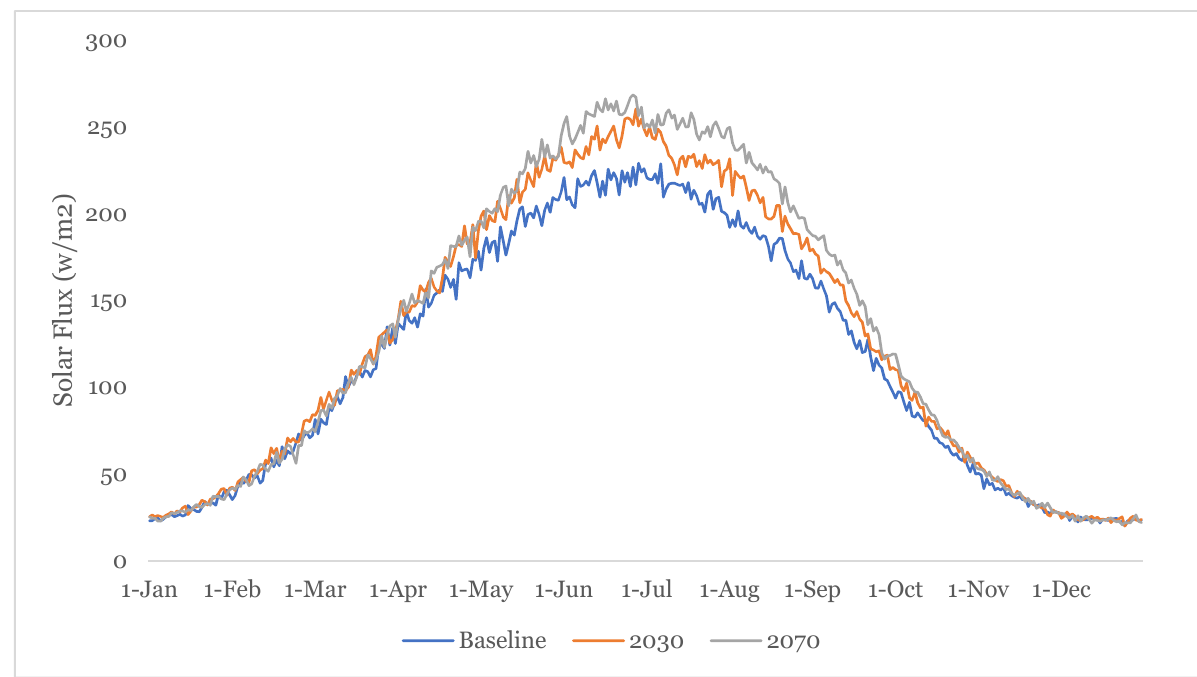
Figure 1. Locations in Wales, clockwise from the top left. (Llangefni, Shotton, Wrexham, Brynmawr, Cardiff, and Narberth).